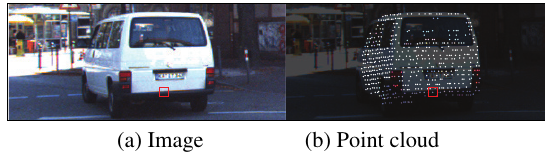
Figure 1: The laser scanner point cloud may be noisy, sparse, prone to systematic errors. We propose an approach to overcome these problems and reconstruct surface of the objects in this pa-